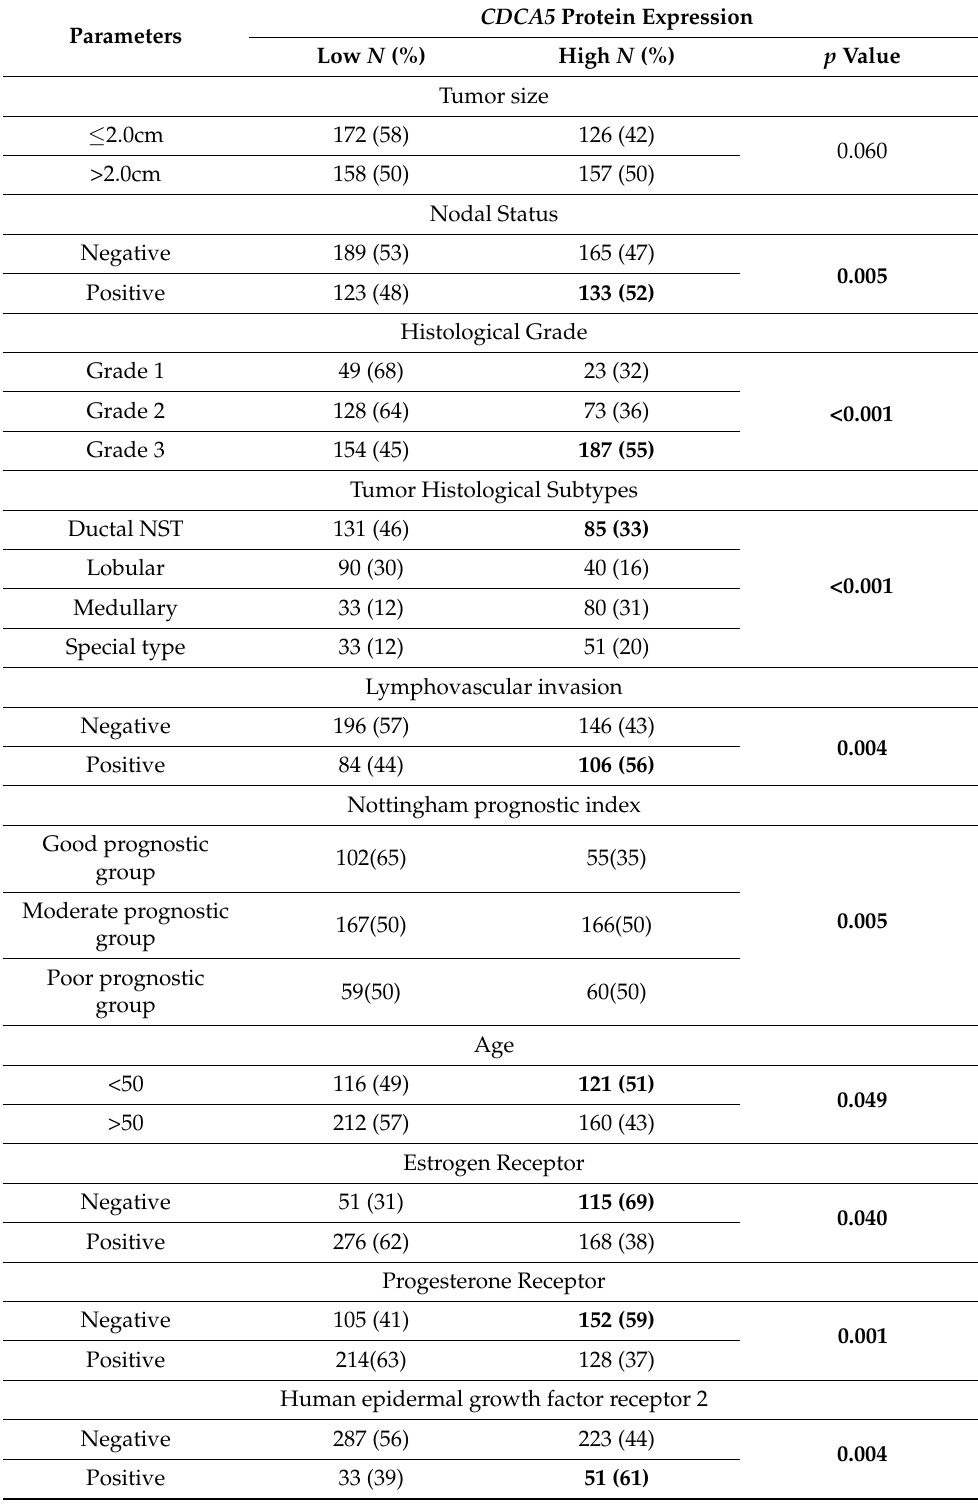
Table 4. Association between CDCA5 protein expression and clinicopathological characteristics of the studies cohort ( n =